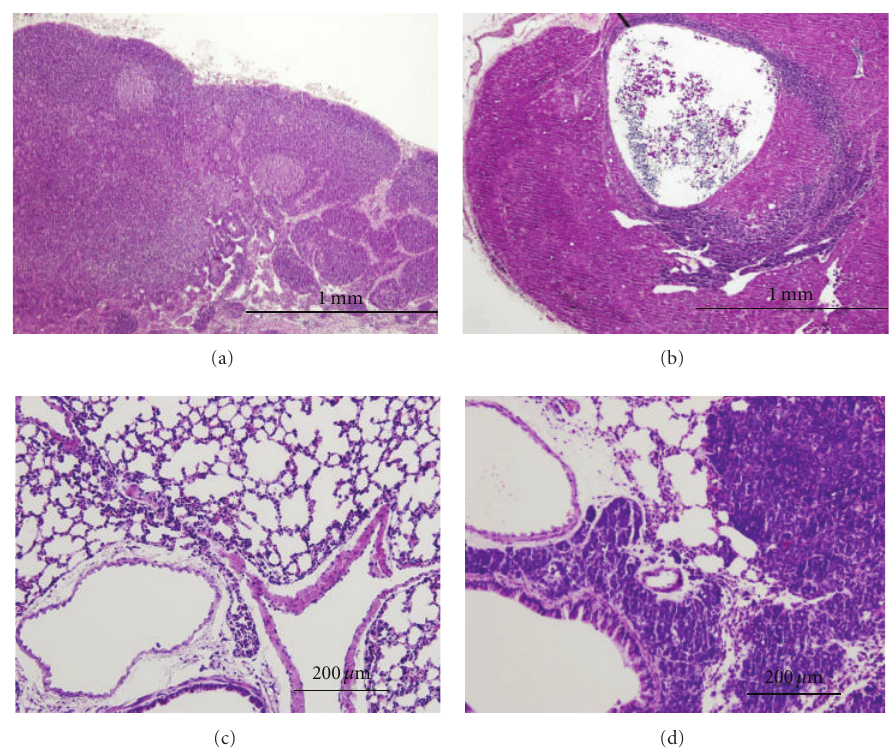
Figure 3: Histopathology by H&E staining of axially lymph nodes (a and b) and lungs (c and d) in mice at 10 weeks postinoculation. Axially lymph node and lung in BJMC338 tumor (a and c) show normal appearance, whereas those of BJMC3879 tumor (b and d) demonstrate metastatic